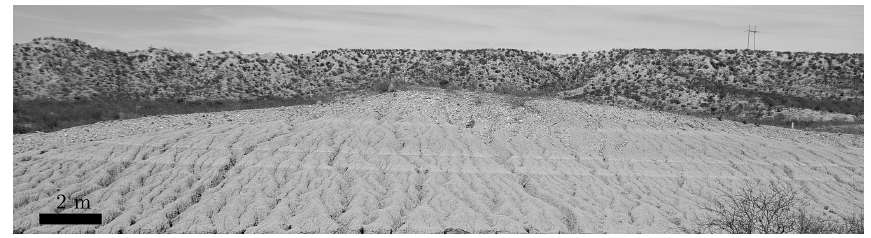
Figure 1. A rilled hillslope near Benson, AZ. Prominent sub-horizontal lines are the stratigraphy of the lake sediments of the